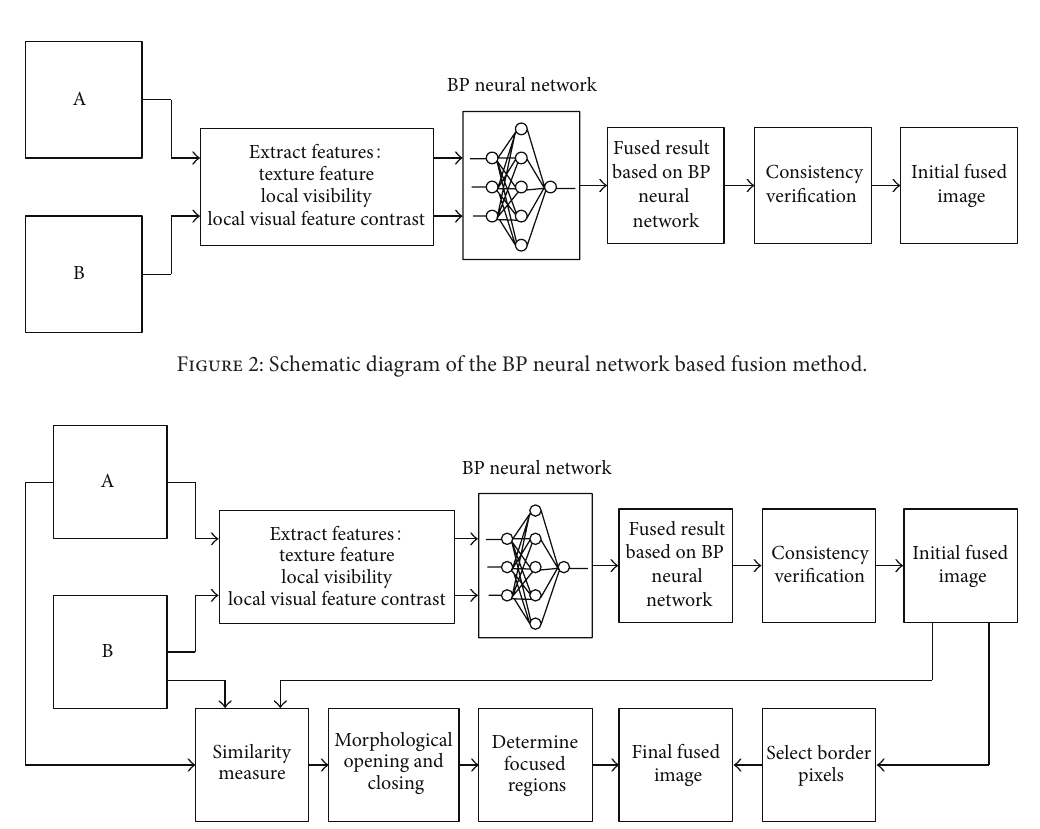
Figure 3: Schematic diagram of the proposed image fusion